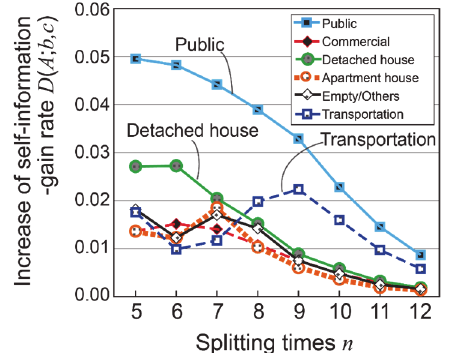
Figure 14 . Self-information-gain rate increase for “public” lots.